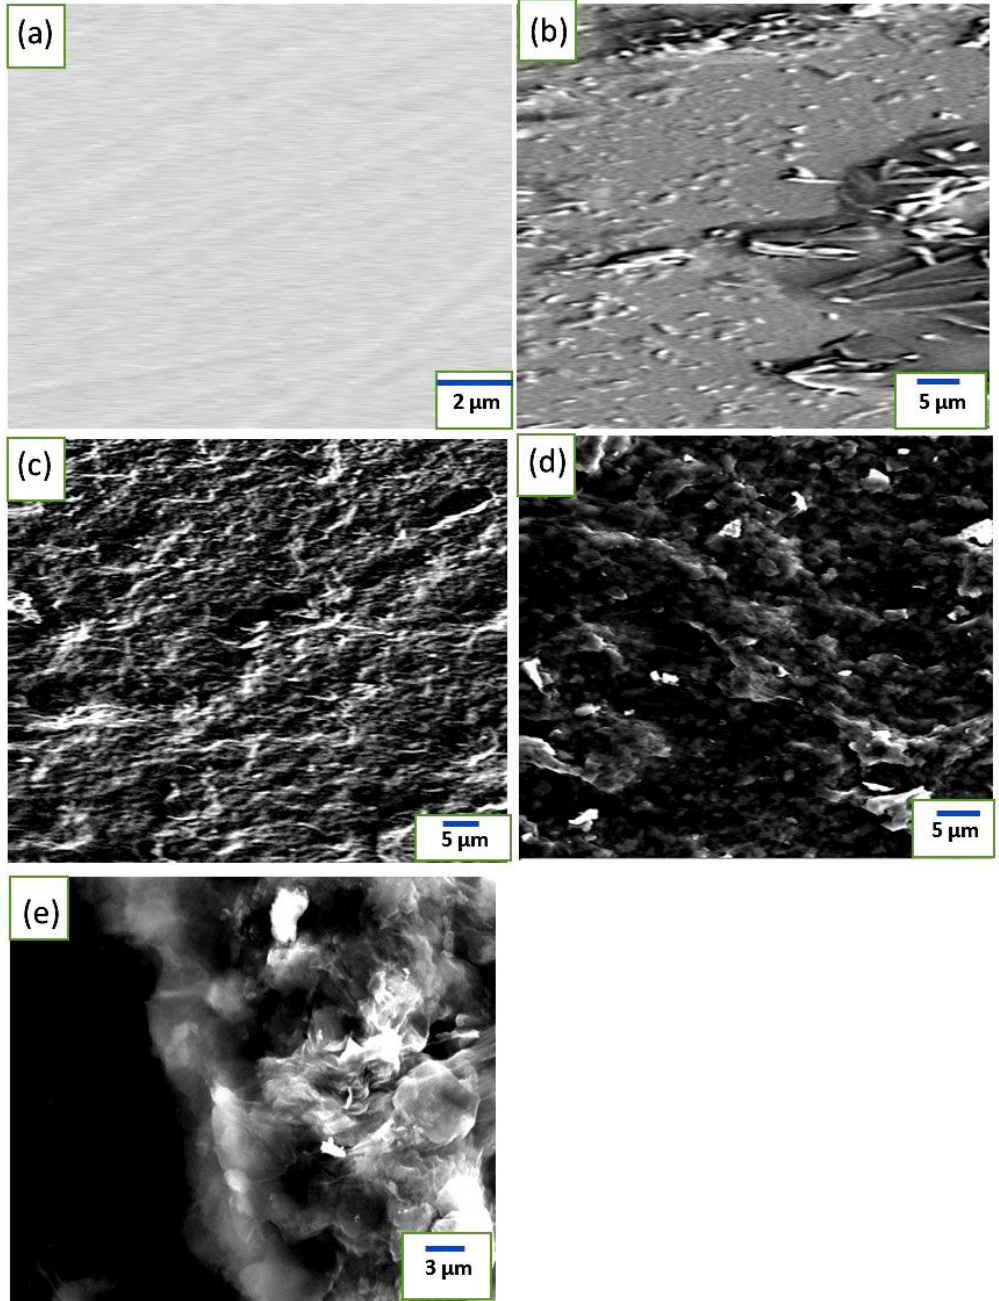
Figure 2. SEM micrographs for ( a ) polished Ni bare, ( b ) Ni/β - Ni(OH) 2 , ( c ) Ni/β - Ni(OH) 2 /4L GO before exposure, ( d ) Ni/β - Ni(OH) 2 /4L GO after exposure, and ( e ) cross - section of Ni/β - Ni(OH) 2 /4L GO.